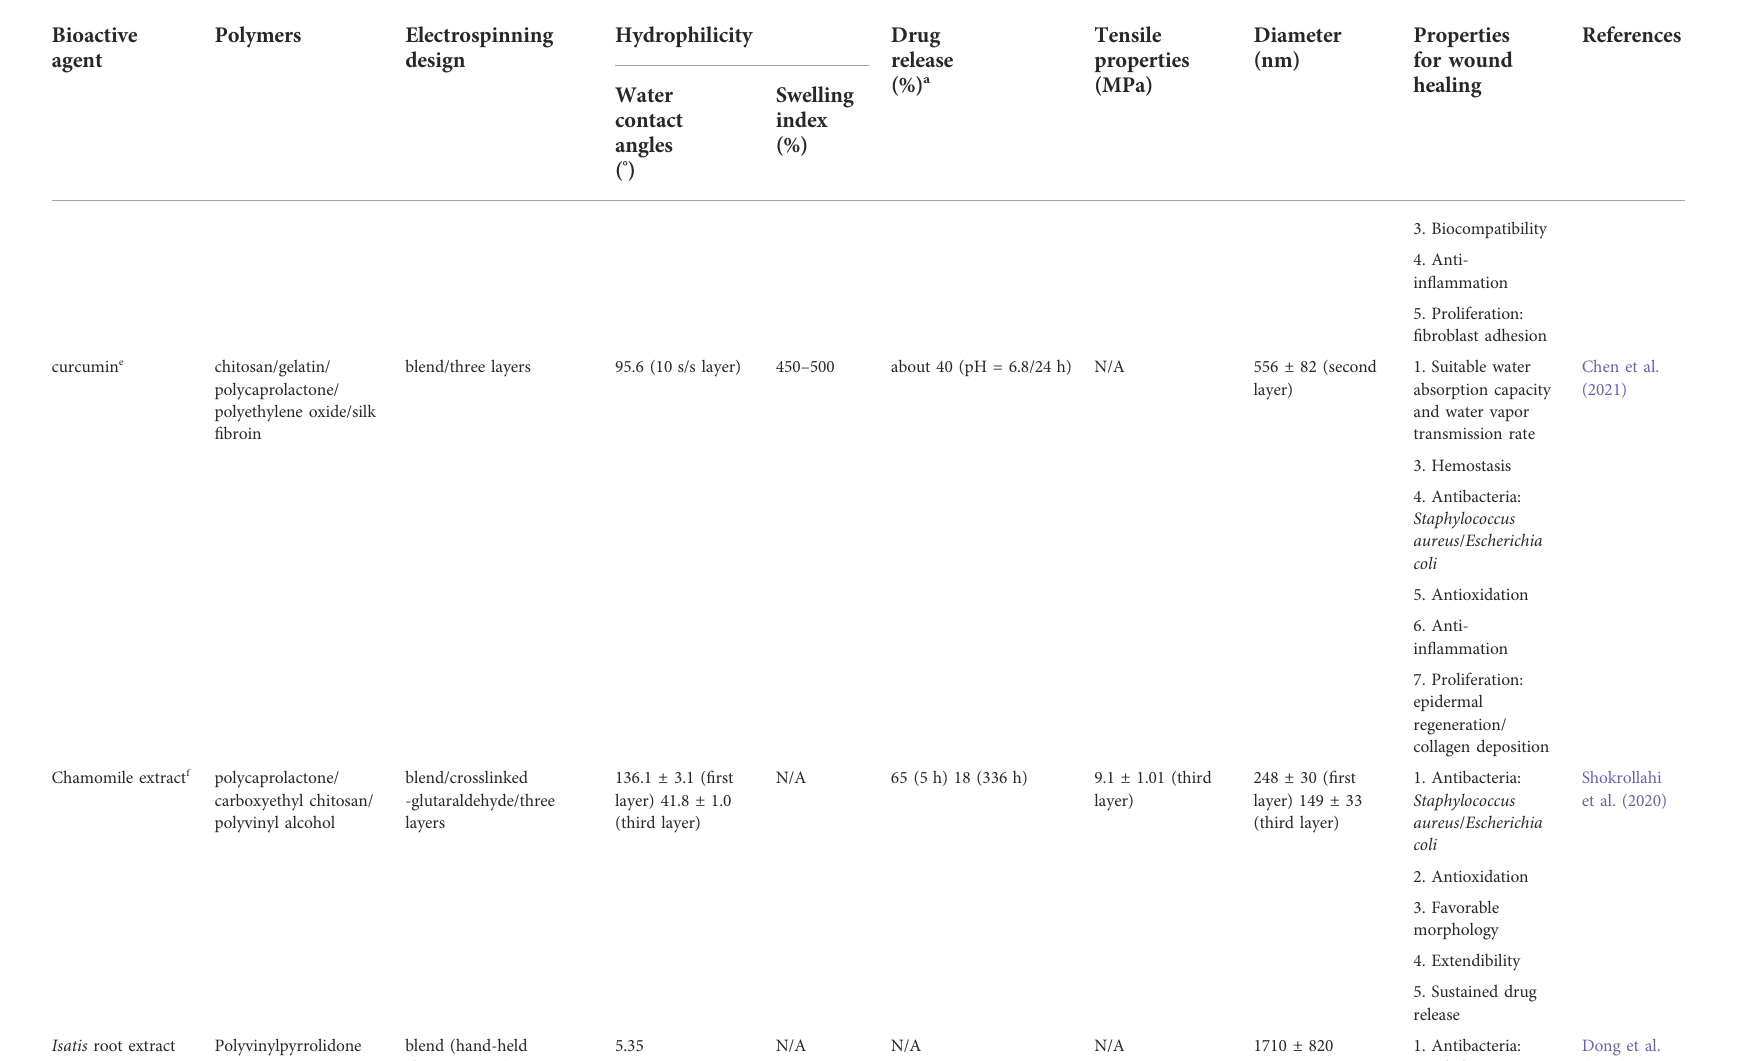
TABLE 1 ( Continued ) Botanicals as loaded-drugs used in electrospinning for wound